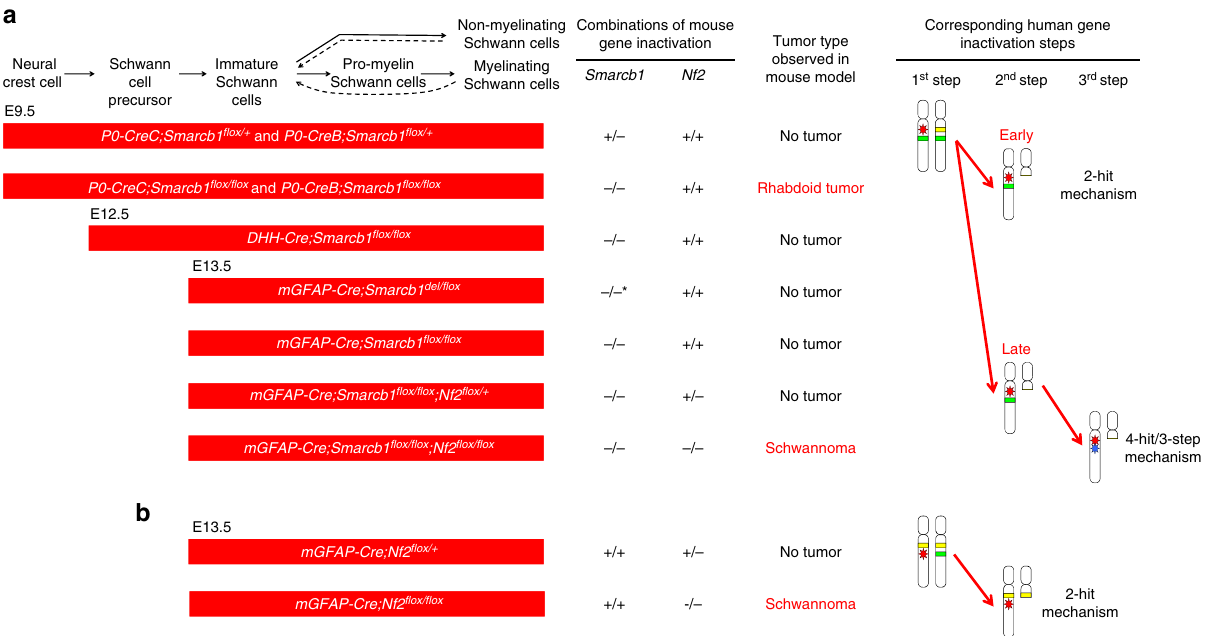
Fig. 7 Proposed model of schwannoma versus RT initiation in the NC-derived SC lineage. Schematic illustration of the different combinations of mouse genotypes modeling different steps of the human 4-hit/3-step mechanism sequence and corresponding tumor phenotypes. a Smarcb1 loss in early NC results in RT development in P0-CreC;Smarcb1 fl ox/ fl ox mice, but is not tumorigenic when occurring at later SC developmental stages ( DHH-Cre;Smarcb1 fl ox/ fl ox and mGFAP-Cre;Smarcb1 fl ox/ fl ox mice). Thus, loss of Smarcb1 does not contribute to schwannoma development in mGFAP-Cre;Smarcb1 fl ox/ fl ox ;Nf2 fl ox/ fl ox mice where Nf2 loss in the SC lineage is suf fi cient for tumor initiation, as b in mGFAP-Cre;Nf2 fl ox/ fl ox mice. *germline Smarcb1 allele